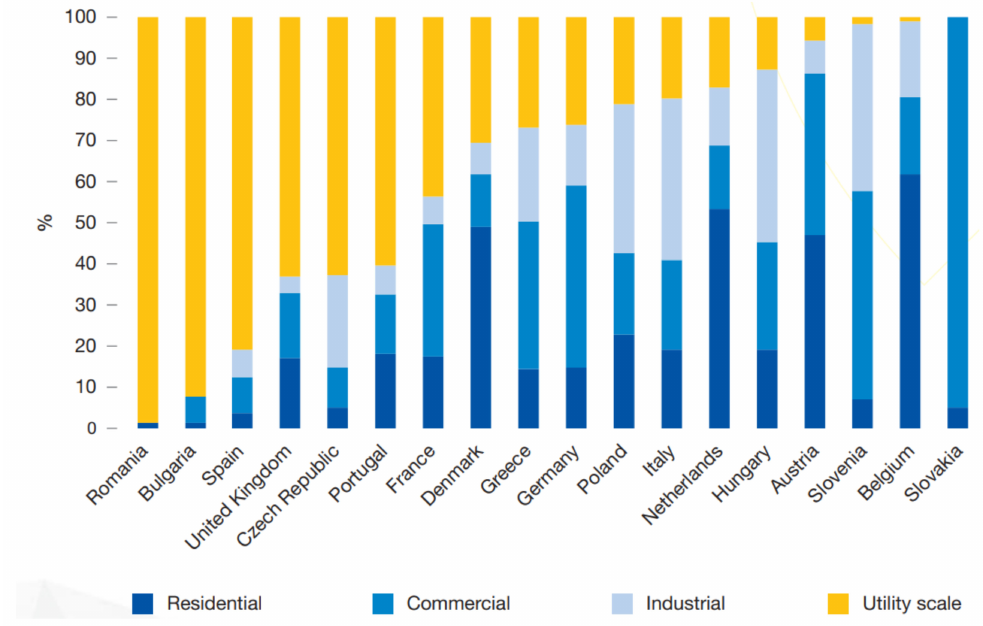
Figure 2. Share of different segments in Solar PV total capacity of EU selected countries until 2018 [22].